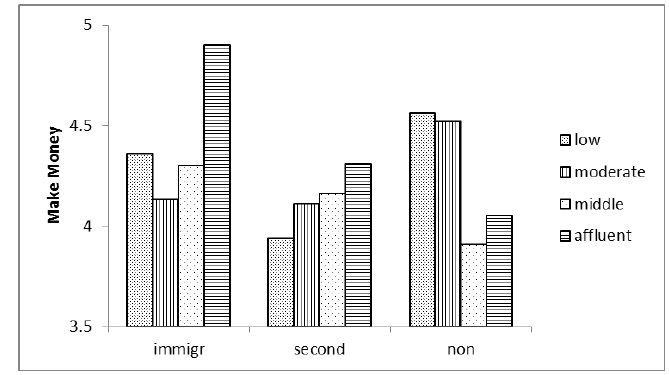
Figure 3 . Economic expectations by immigration history and parent income